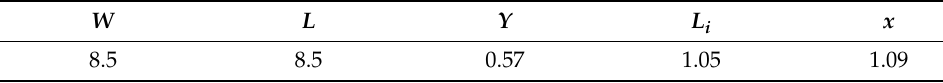
Figure 6. Effect of the dipole angle on the antenna array reflection coefficient. Table 1. Optimum dimensions of the DAA in mm.